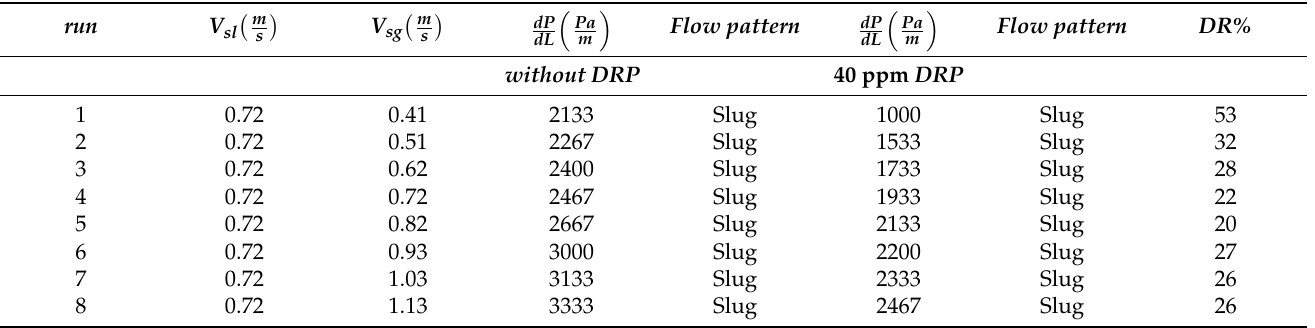
Table A2. Frictional Pressure Drop Associated with the Slug Flow Regime and Drag Reduction Effectiveness Using 40 ppm DRP.